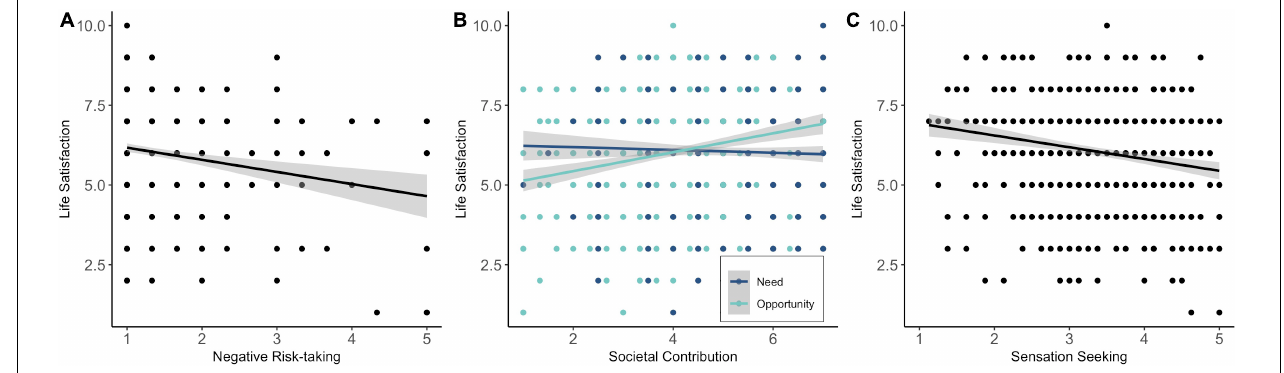
FIGURE 7 | Negative risk-taking (A) , societal contribution (B) , and sensation seeking (C) as predictors of life satisfaction during